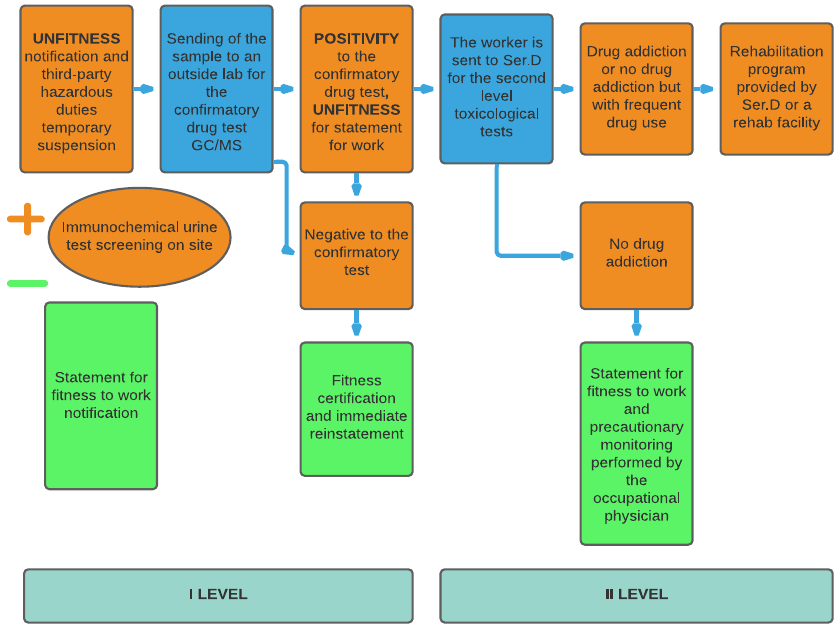
Figure 1. Procedure for issuing the fitness or unfitness statement by the occupational doctor (OD).